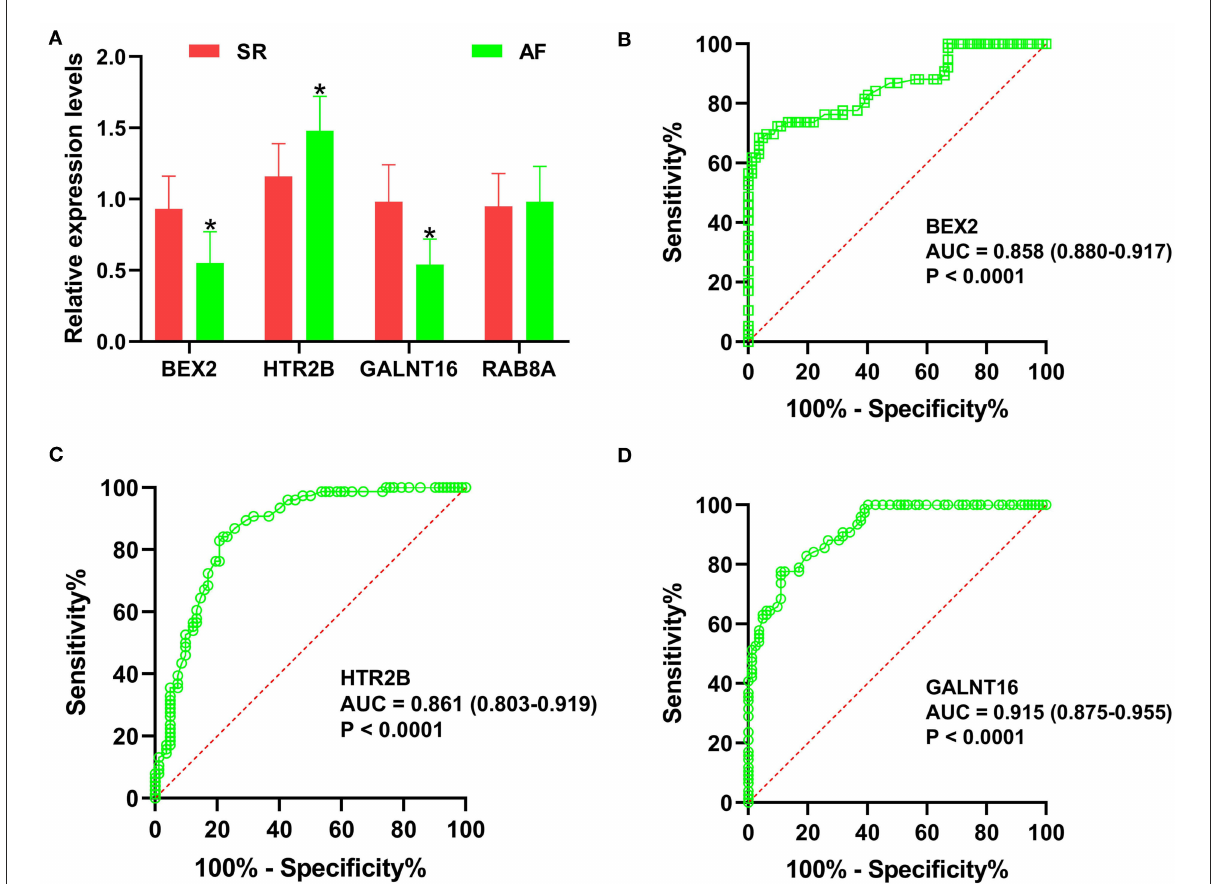
FIGURE8 Validation of the key genes in AF samples. (A) The relative expression levels of BEX2 , HTR2B , GALNT16 and RAB8A in AF patients, * P < 0.01. ROC curve analysis of BEX2 (B) , HTR2B (C) and GALNT16 (D) in AF